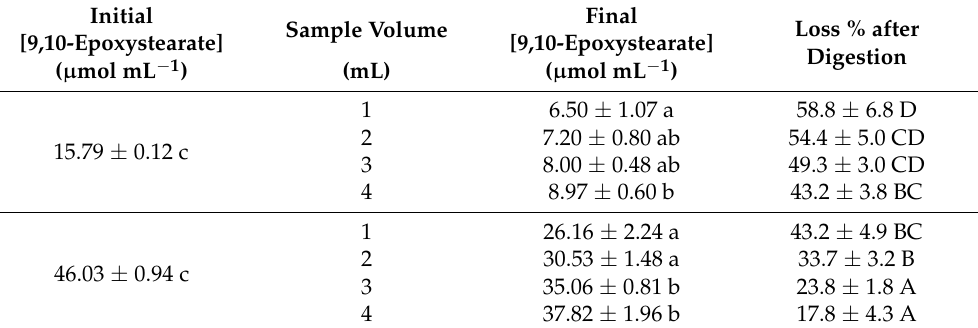
Table 2. Quantitation of methyl 9,10-epoxystearate before and after simulated gastric digestion.